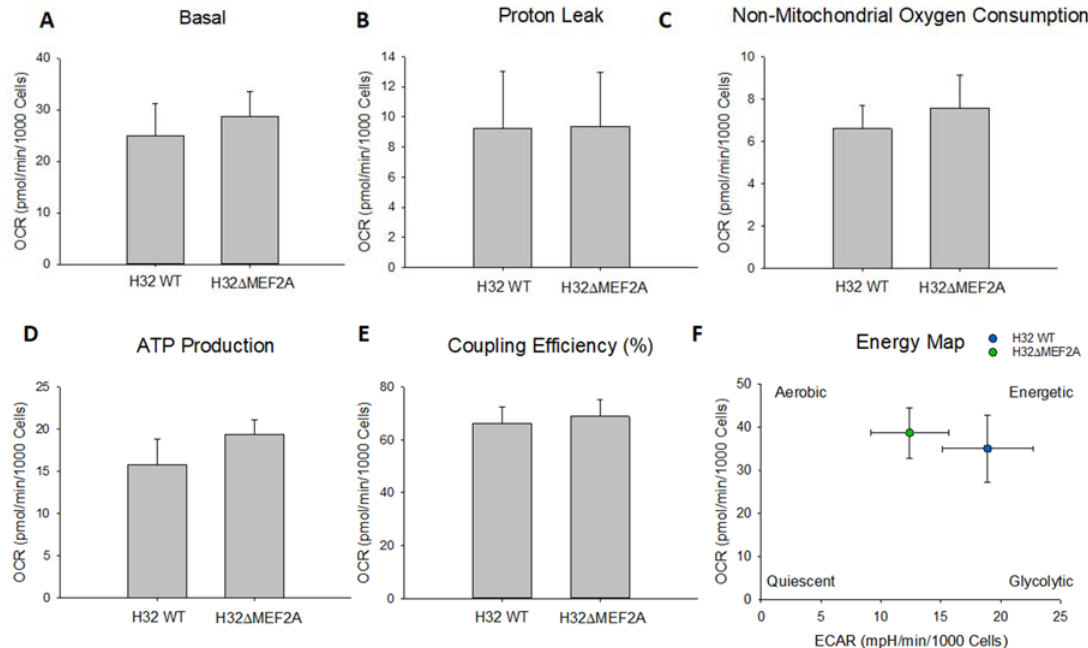
Figure A1. Mitochondrial function in H32 wild ‐ type and H32 Δ MEF2A cells. n = 3 per group.